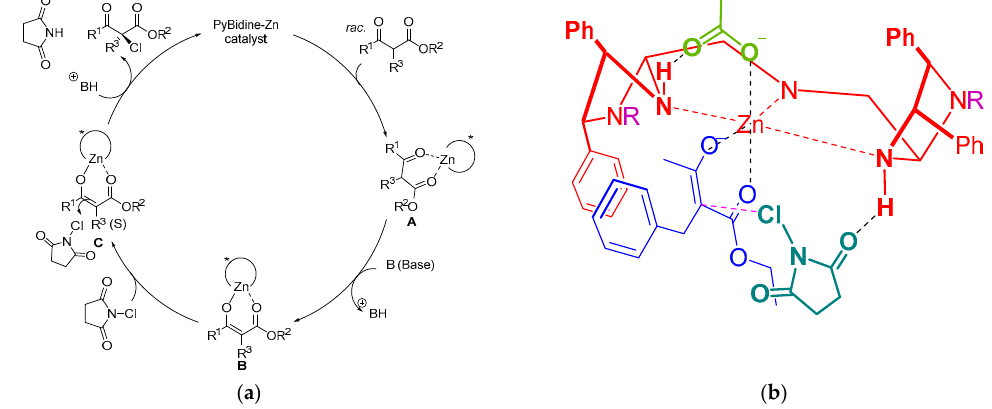
Figure 1. Proposed reaction mechanism of asymmetric chlorination of β -ketoesters catalyzed by N -PFB-PyBidine ( L10 )-Zn(OAc) 2 complex: ( a ) catalytic cycle; ( b ) reaction model.